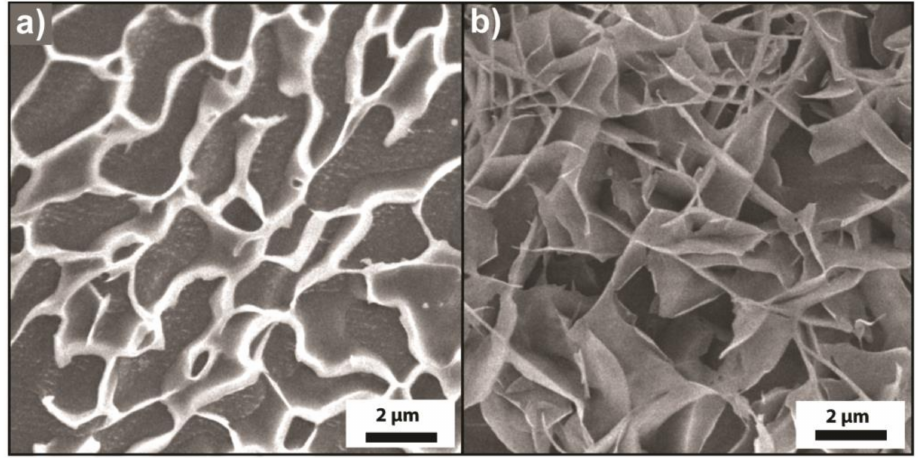
Figure 7. Cryo SEM imaging of hydrogel samples: ( a ) PVP 41k - b -POEGMA 22k (3.3 wt.%)/ α -CD (10.4 wt.%) and ( b ) POEGMA 22k (1.7 wt.%)/ α -CD (10.4